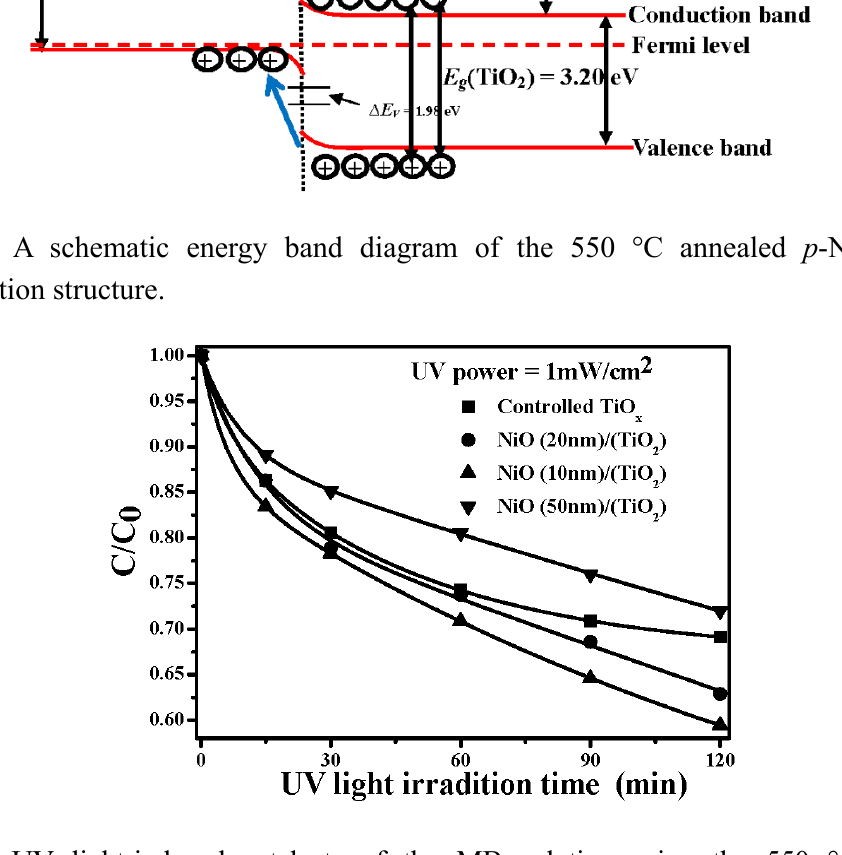
Figure 8. UV light-induced catalysts of the MB solution using the 550 °C-annealed p -NiO/ n -TiO 2 nanocomposite structures, with the thickness of the NiO film being 10, 20 and 50 nm, respectively.